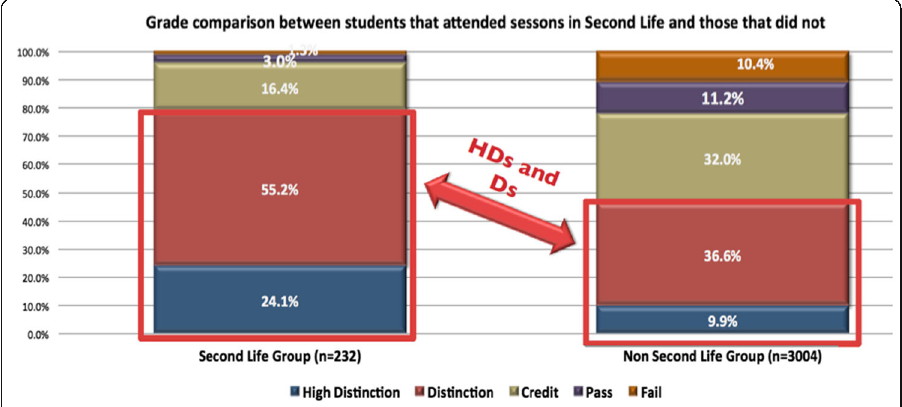
Fig. 10 Impact of learning in a virtual world of 3576 students across a 4-year